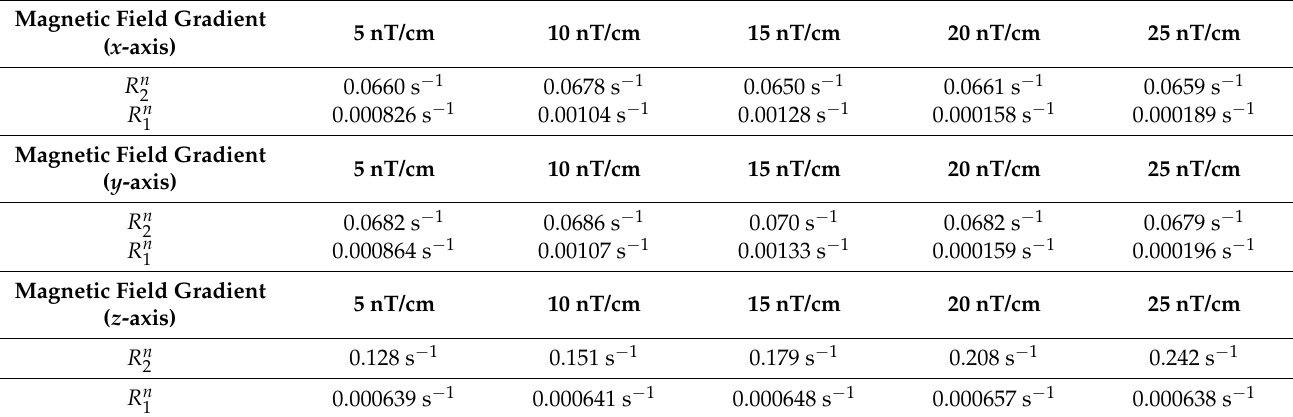
Table 4. Experimental results of R n applied